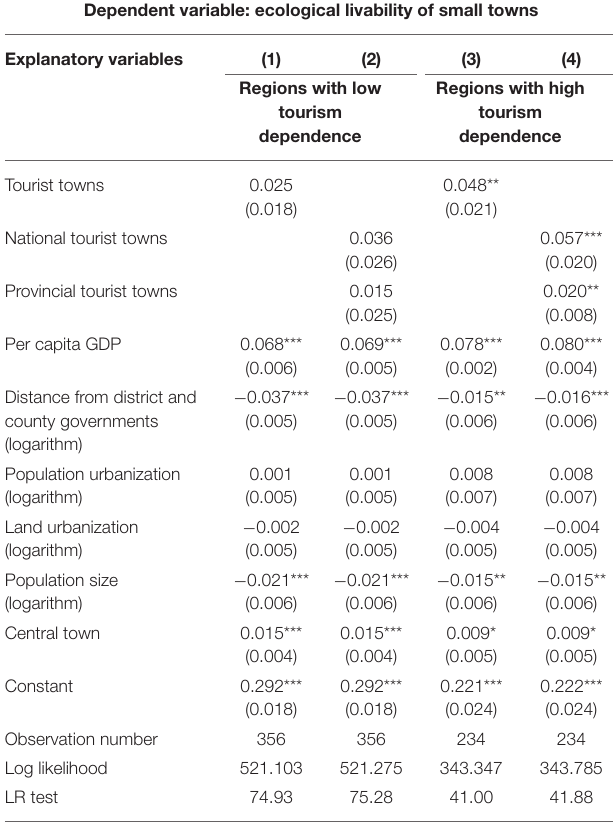
TABLE 6 | Results based on the division of tourism dependence. Dependent variable: ecological livability of small